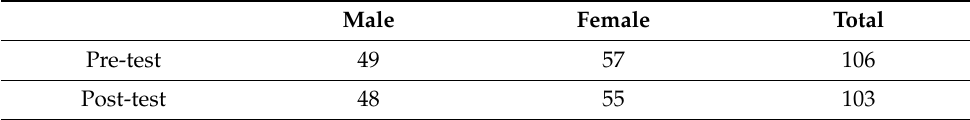
Table 1. Study Subjects from Inji Middle School, Seosan, South